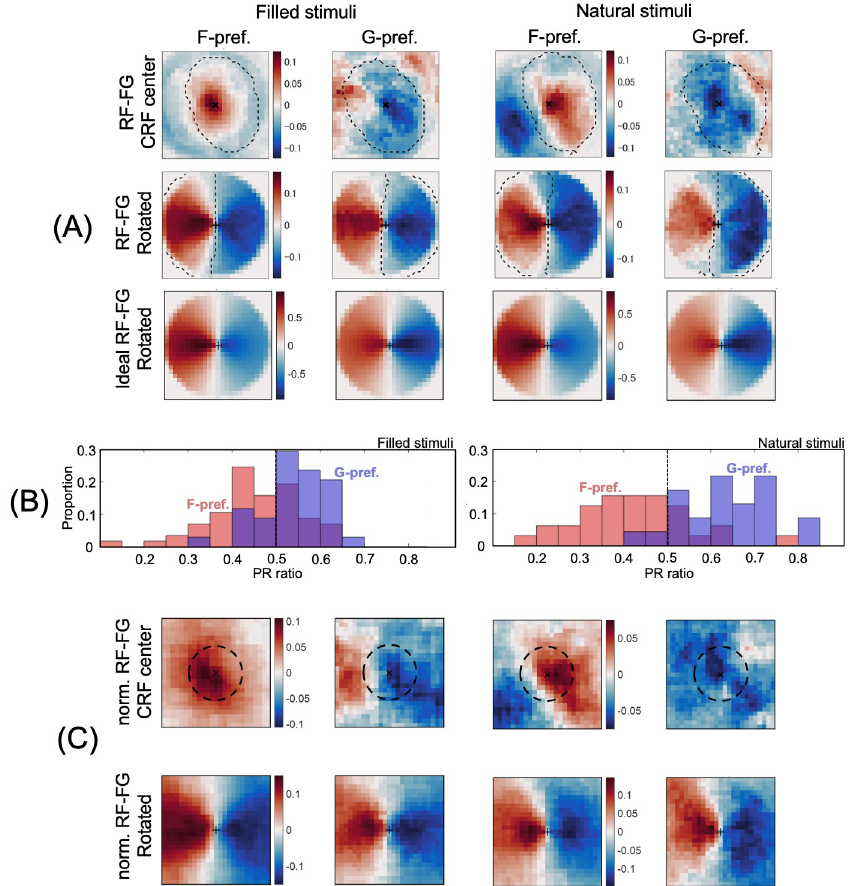
Fig 4. The mean RF-FG STA s across neurons. (A) The mean RF-FG STA s with aligned CRFs estimated from filled and natural stimuli (the left and right two columns, respectively). The top row shows the mean RF-FG STA s across the neurons. The left and right columns show the RF-FG STA s of the neurons that preferred figure and ground, respectively. The reddish and blueish colors indicate the regions that respond to figure (+) and ground (–), respectively, with the deeper colors representing the greater magnitudes. The preferred regions appear around the CRF center as indicated by the black cross at the panel center. The middle row shows the mean RF-FG STA s with rotation; individual RF-FG STA s were rotated with respect to the patch center to align the center of gravity of the figure and ground regions to the left and right, respectively. The magnitudes were normalized by the maximum value, and the colors were normalized for each panel. The extent of panels was identical to that of the stimulus patches. The dotted lines indicate the extent of the preferred region in the ideal RF-FG STA s. The bottom row shows the mean ideal RF-FG STA s with rotation. (B) The distribution of the extent of the preferred subregions in PR ratio. The red and blue colors indicate the ratios for figure- and ground-preferred neurons, respectively. (C) The mean RF-FG STA s with normalization (scaling) by the CRF extent. The dotted lines indicate a circle with the area equal to the mean area of the scaled CRFs. The same conventions were used as in panel (A).